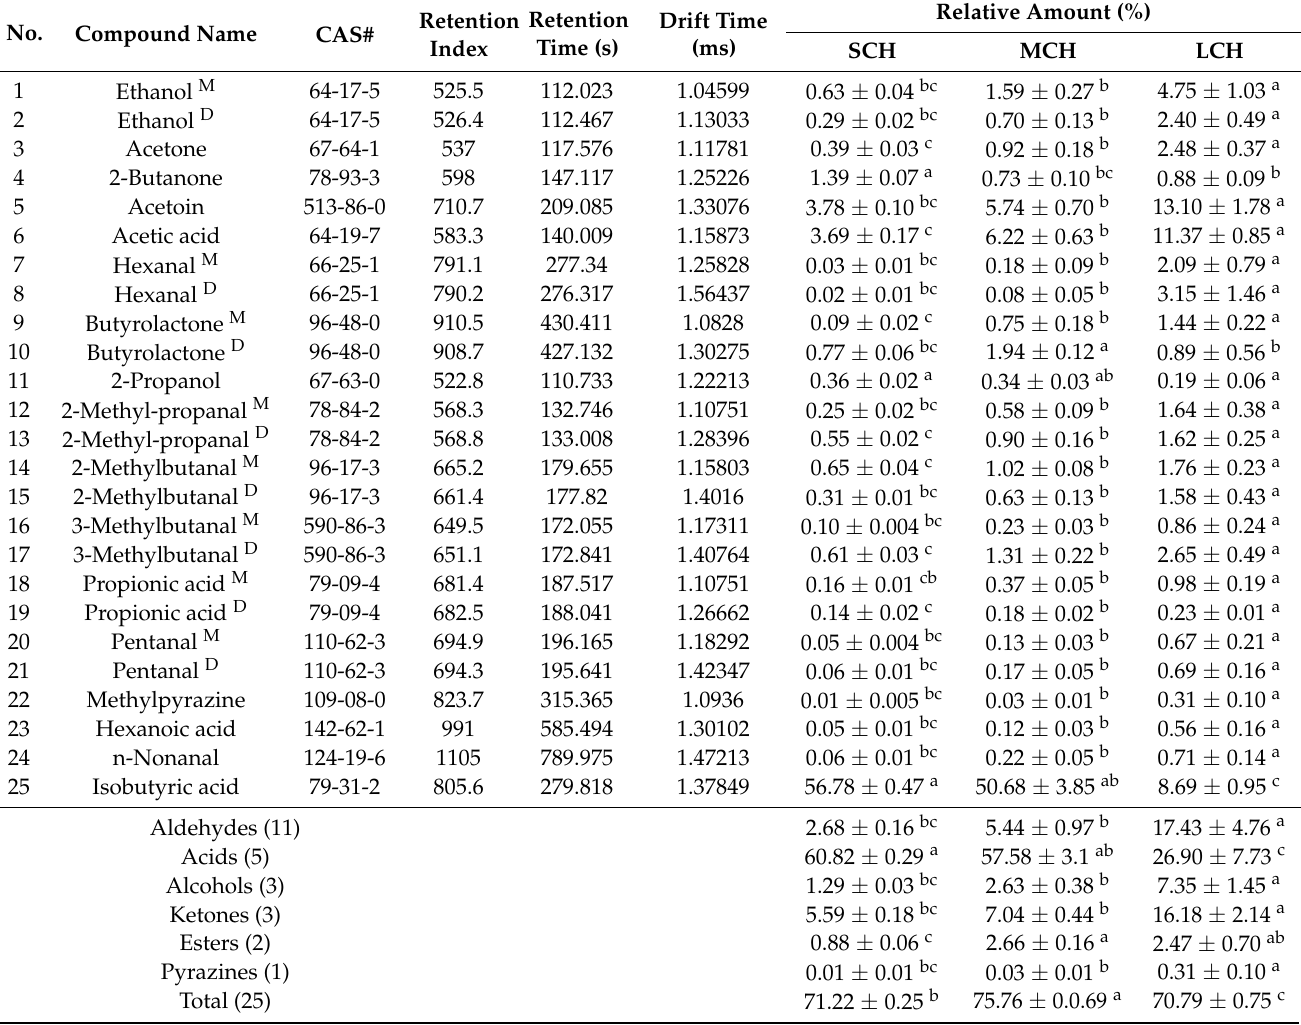
Table 5. Identified volatile compounds in coconut haustorium 1 .